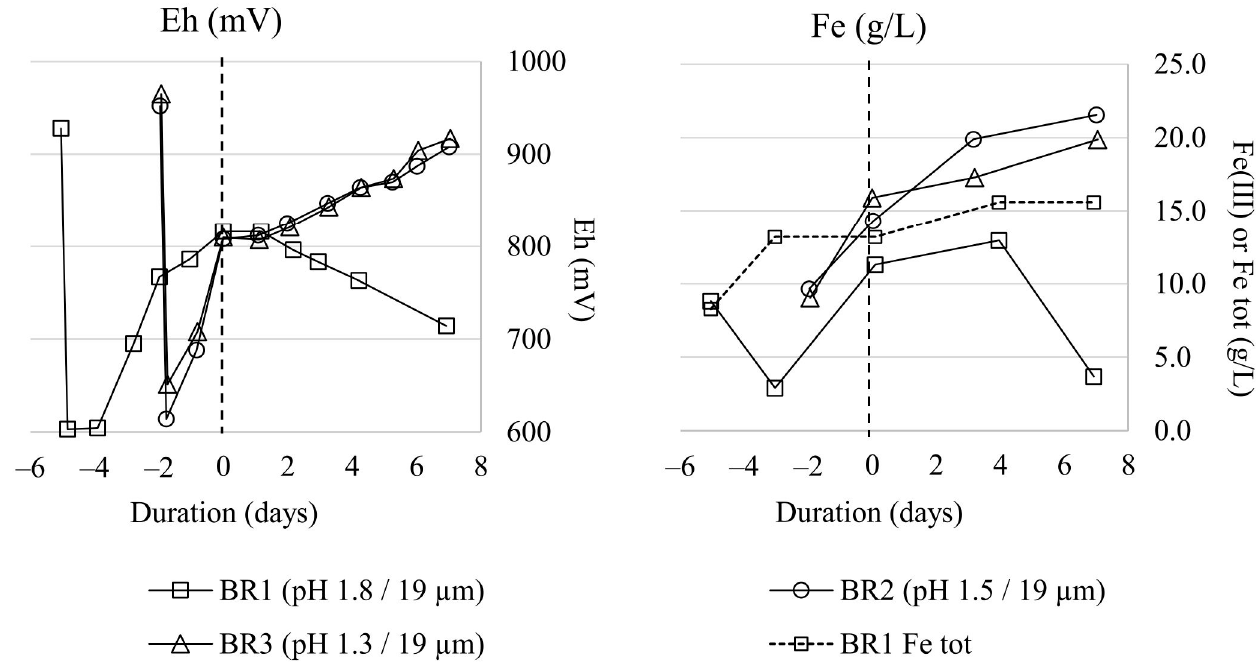
Figure 1. Evolution of Eh, Fe(III) and total acid dissolving Fe (only for BR1) concentration in bioleaching reactors with different operating pH values. The dashed vertical line illustrates the starting point of 7-day bioleaching tests. The negative days illustrate the length of ramp-up phase.